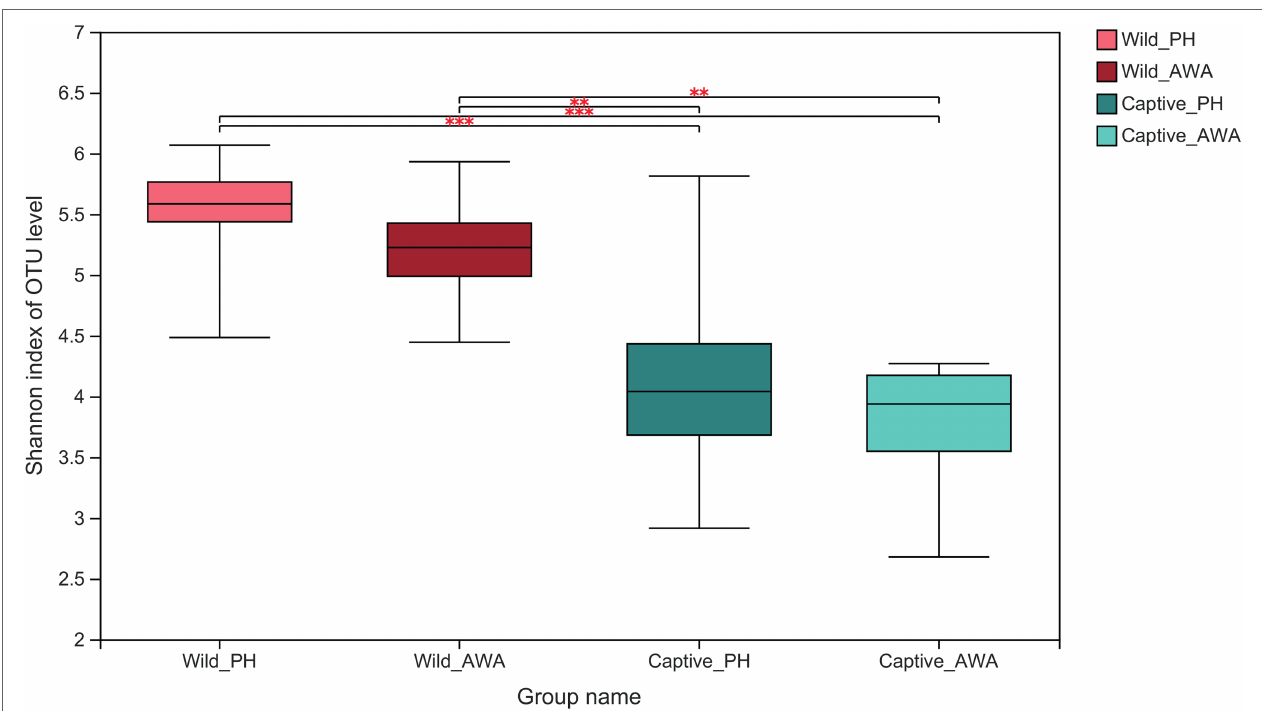
FIGURE 2 | Wilcoxon rank-sum test for differences in Alpha diversity (Shannon index) between groups on the OTU level. ** p < 0.01 and *** p <